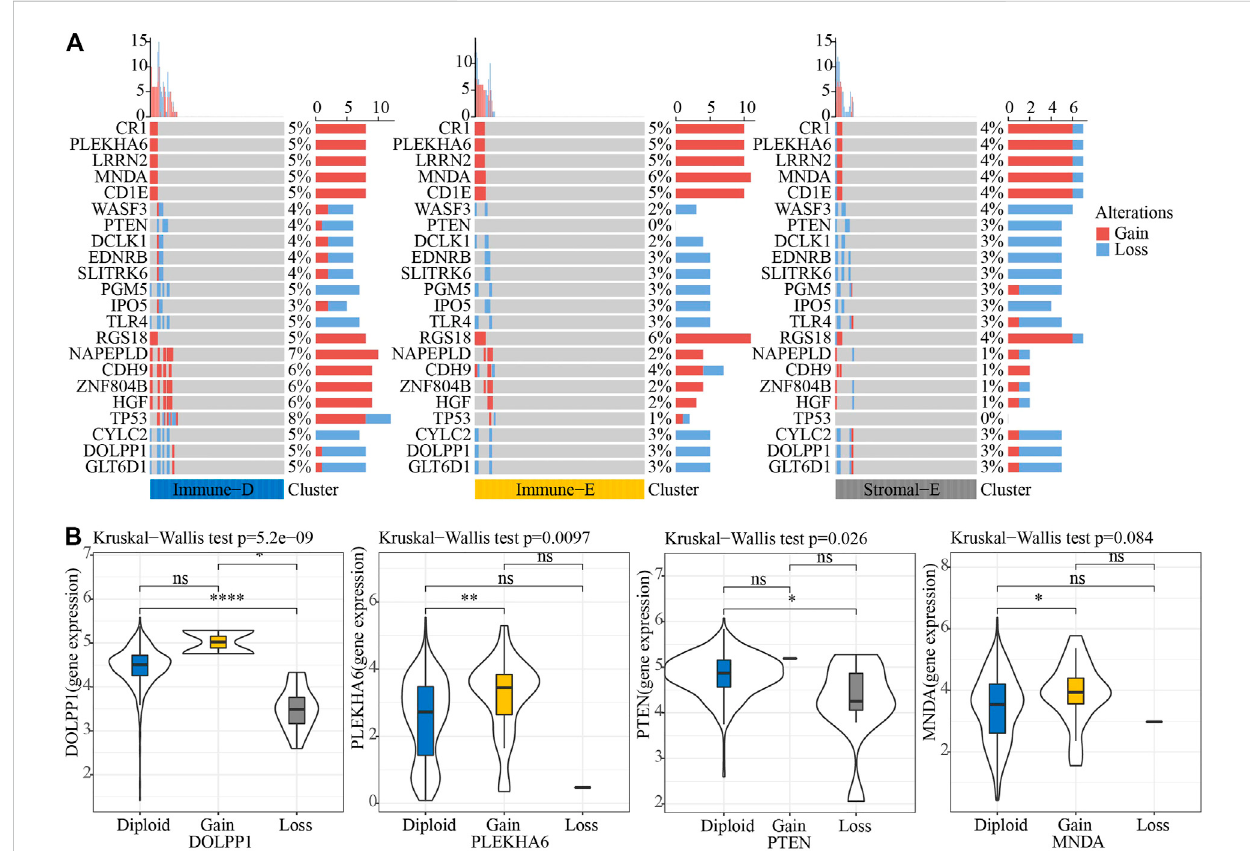
FIGURE 5 CNV analysis of tumor-driving genes. (A) CNV analysis of tumor-driving genes among the three molecular subtypes. (B) Expression differences of four genes in three CNV groups. * p < 0.05; ** p < 0.01; **** p < 0.0001; ns: no signi fi cance.